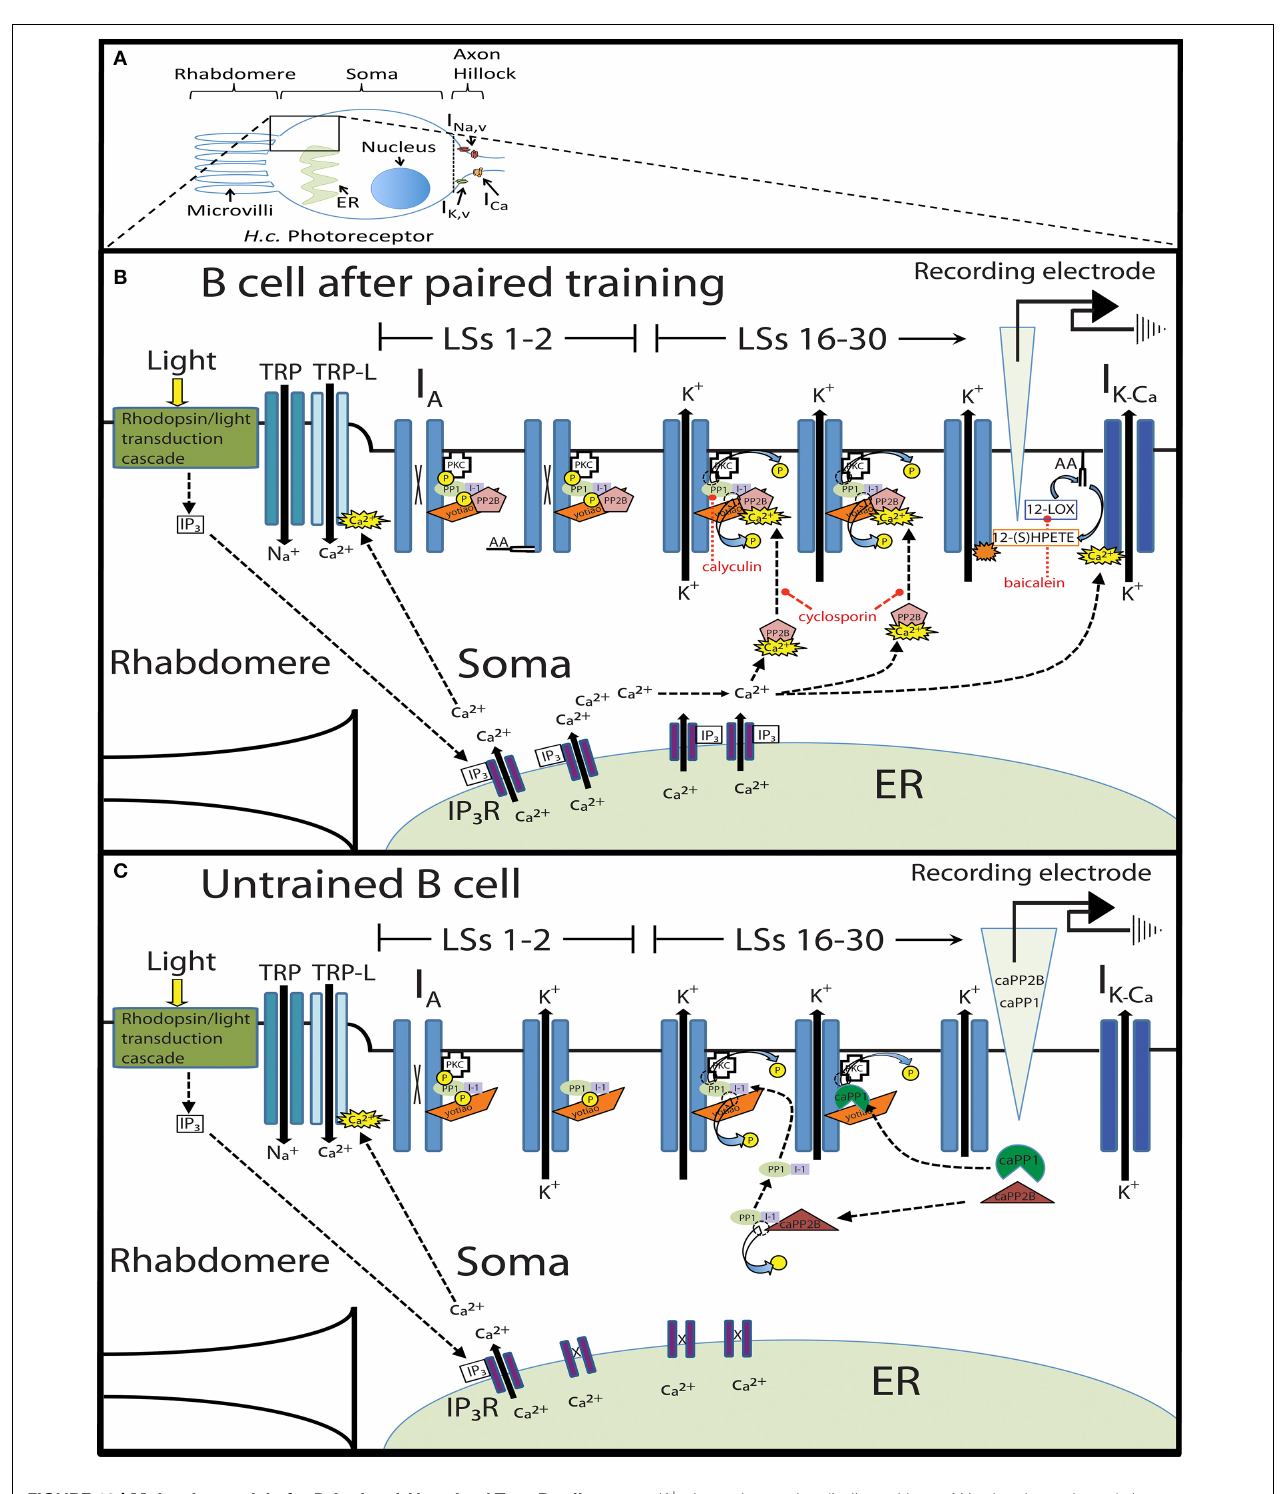
K + channels are shut (indicated by an X in the channel pore) due to PKC-mediated phosphorylation of the channel itself or channel-associated proteins (P indicates a phosphate group). Paired conditioning also mobilizes inhibitor-1/PP1 complexes and PP2B to K + channel signaling complexes, where both inactive phosphatases are localized via anchoring proteins such as yotiao/AKAP. Paired conditioning also activates AA, which facilitates